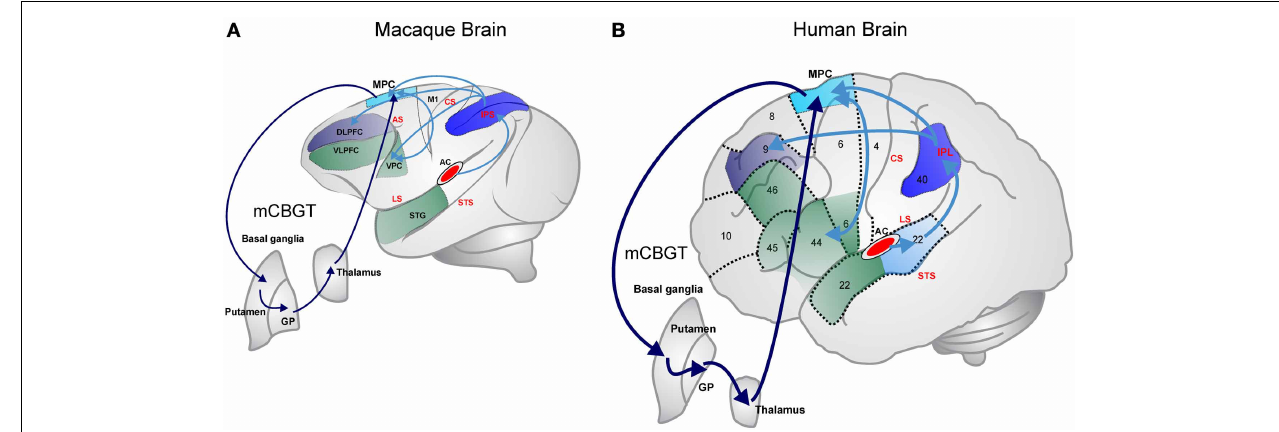
FIGURE 1 | Dorsal auditory stream in primates (marked in blue) that focus on processing sequential and temporal information. (A) In the Rhesus monkey; (B) in the human. The dorsal stream starts in the interior/posterior parietal cortex that strongly connects with the medial and dorsal premotor areas, which in turn are reciprocally connected with ventral premotor and Broca’s areas. Parietal areas also are connected with the dorsolateral prefrontal cortex. Medial premotor areas form the skeletomotor